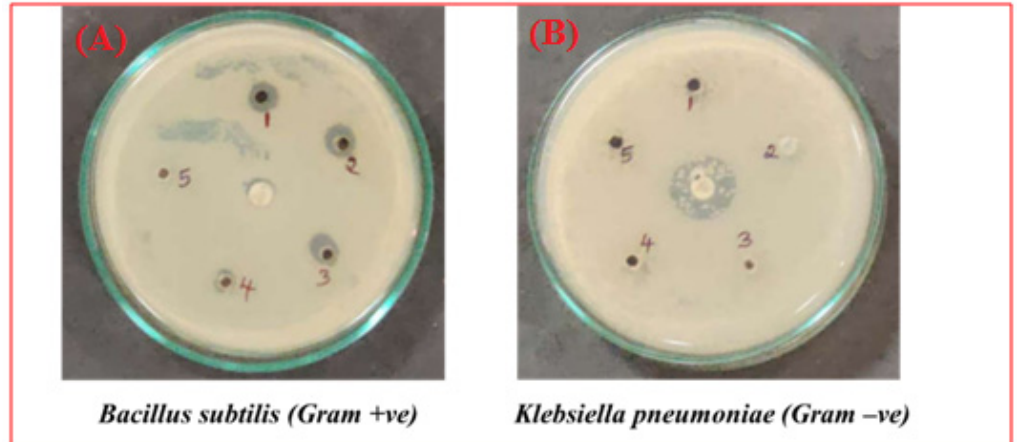
Fig. 12. Antibacterial activity of ZO3 nanoparticles using the agar well diffusion method. A- Bacillus subtilisand B- Klebsiella. pneu- moniae . ZO3 nanoparticles were diluted at the concentrations 1: 50mg/ml; 2: 25mg/ml; 3: 12.5mg/ml, 4: 6.25mg/ml, 5: Sterilised water and center will be Gentamicin (antibiotic), wells werefilled with 25μl of the